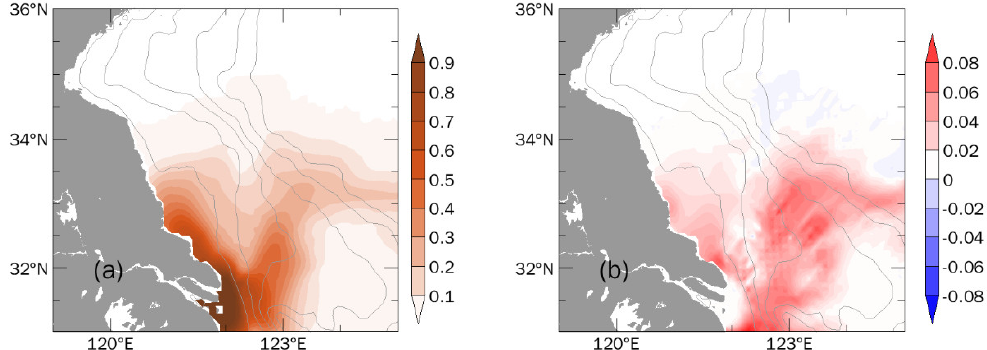
Figure 8. Simulated distribution of the passive tracer ( a ) in Exp.C and ( b ) anomaly distribution in Exp.R at the sea surface in late June with the bathymetry.